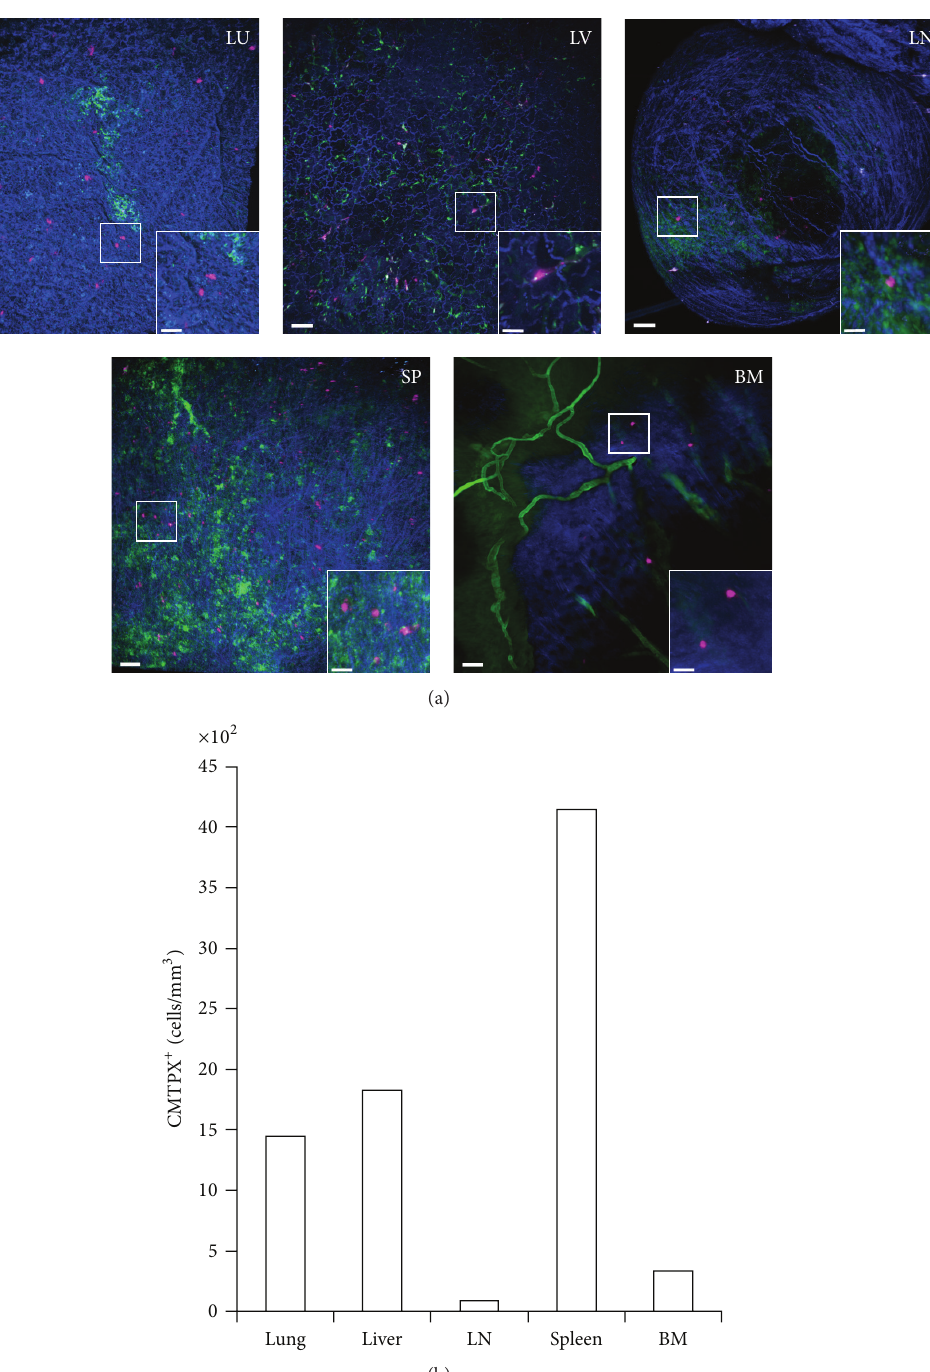
Figure1:DistributionofCMTPX-labeledhMSCs24hoursafteri.v.injectionintoaC57BL/6mouse.FITC-dextranwasinjected15–30minutes before intravital TPM imaging to highlight the vasculature. The calvarium bone marrow (BM) was imaged immediately and all other tissues were removed and fixed overnight in 2% PFA for whole-organ TPM imaging the next day. (a) Representative high-resolution TPM images of lung (LU), liver (LV), lymph node (LN), spleen (SP), and bone marrow (BM) are shown. Blue: collagen (second-harmonics); Green: FITC- dextran vessel dye; Magenta: infused hMSCs. Outset scale bars = 50 𝜇 m; inset scale bars = 20 𝜇 m. (b) Numbers of CMTPX + hMSC cells per mm 3 of imaged tissue were